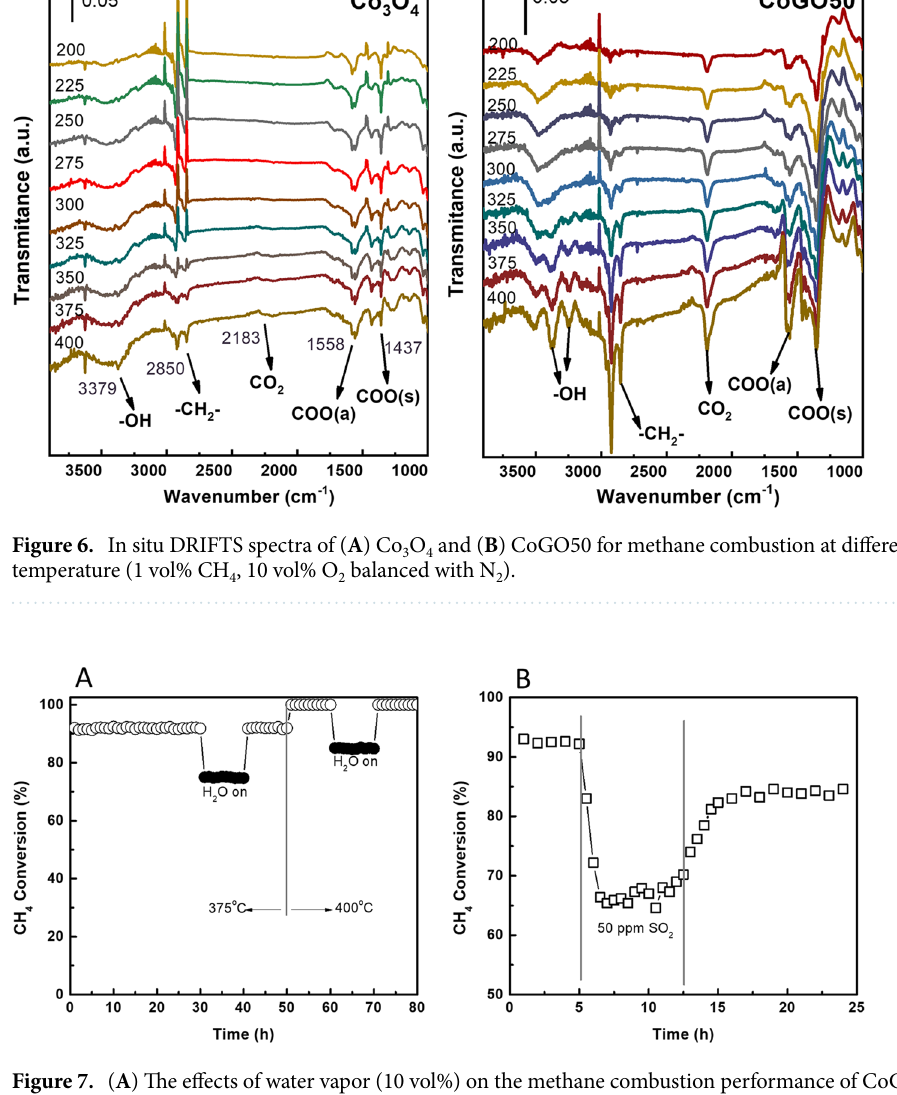
Figure 7. ( A ) The effects of water vapor (10 vol%) on the methane combustion performance of CoGO50 and ( B ) The effects of 50 ppm SO 2 on the methane conversion over CoGO50 sample at 350 °C (1 vol% CH 4 , 10 vol% O 2 and N 2 and GHSV = 30,000 mL g −1 h −1